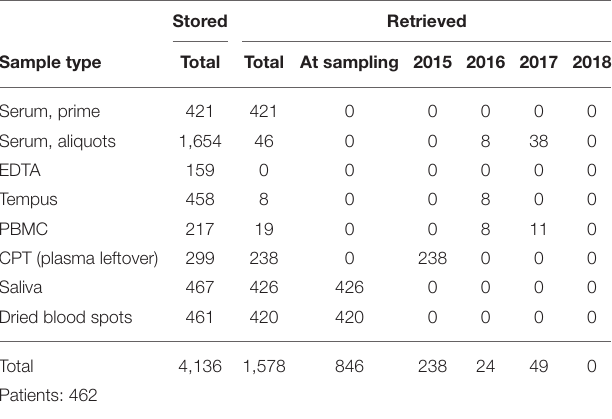
TABLE 2 | Community-based